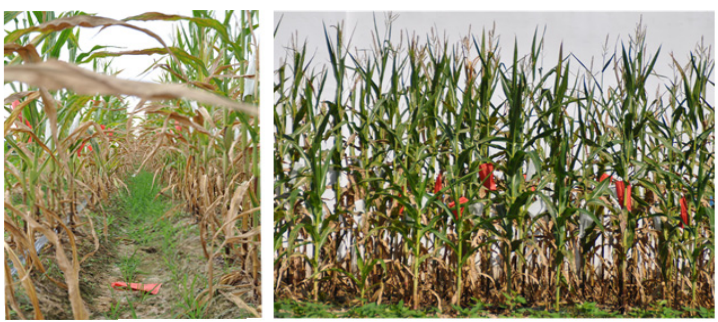
Figure 1. Maize experimental field.